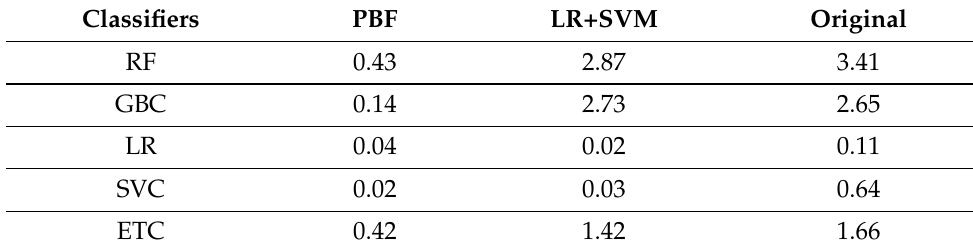
Table 15. Computational cost (time in seconds) of machine learning models.